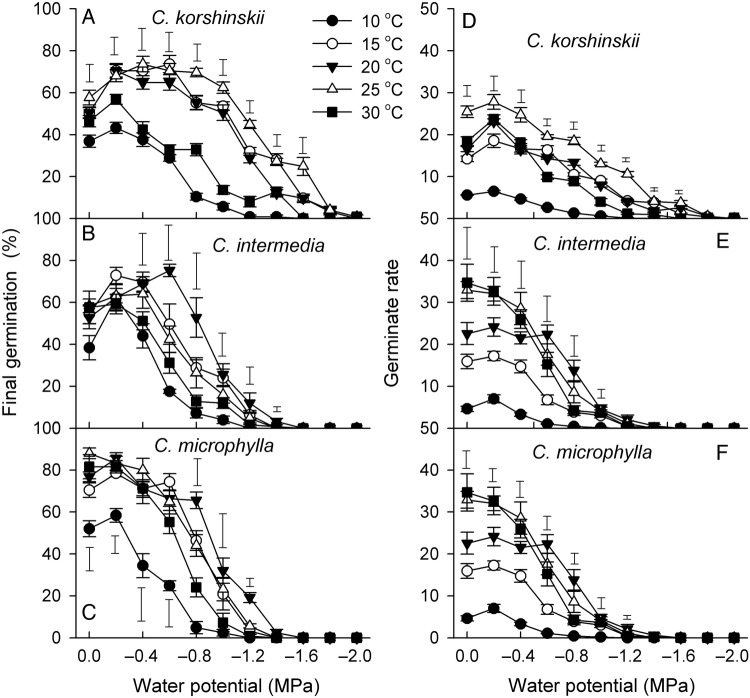
Final germination percentages and rates (mean ± SE, n = 5) of three Caragana species under different temperatures and WPs. Error bars above (below) the data points are the LSD values at P = 0.05, and no error bar means not significant (P > 0.05).